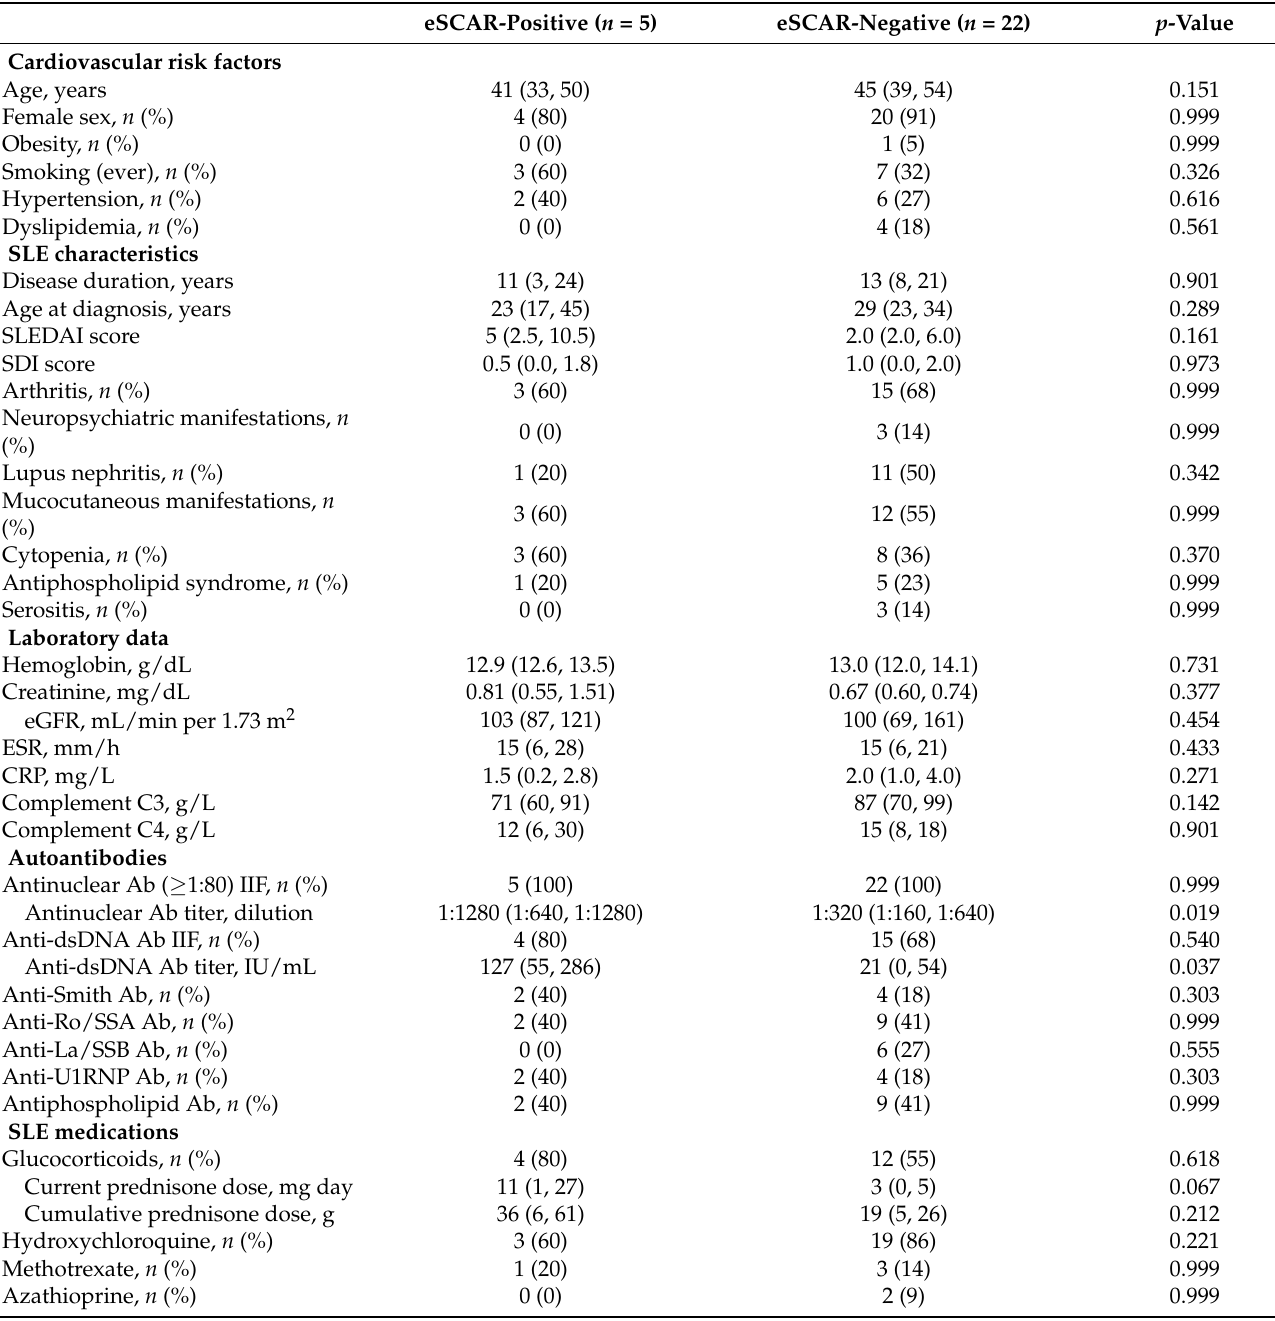
Table 3. Main clinical and biochemical characteristics in eSCAR-positive and eSCAR-negative patients with SLE. eSCAR-Positive ( n = 5) eSCAR-Negative ( n = 22) p